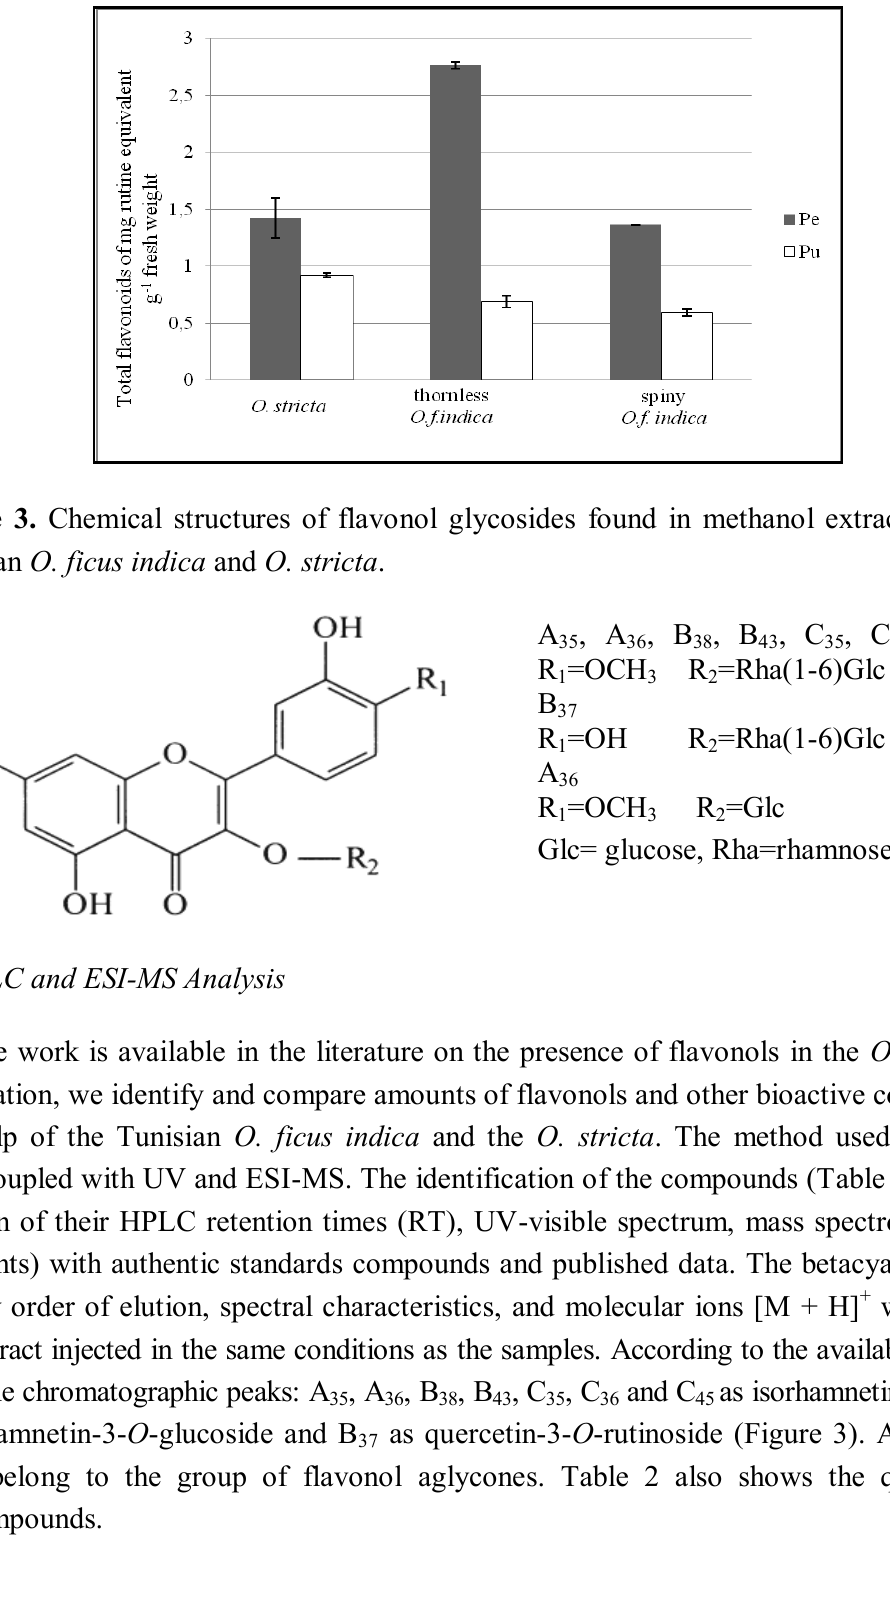
Figure 2. Total flavonoid content of peel (Pe) and pulp (Pu) of three Tunisian Opuntia ( O. ) forms. Results are expressed as mg rutin equivalents g −1 fresh weight (mean ± SD, n = 3) . Means of triplicates pulp and pulp indicate no significant difference (level of significance p < 0.05) between the three Tunisian Opuntia forms.